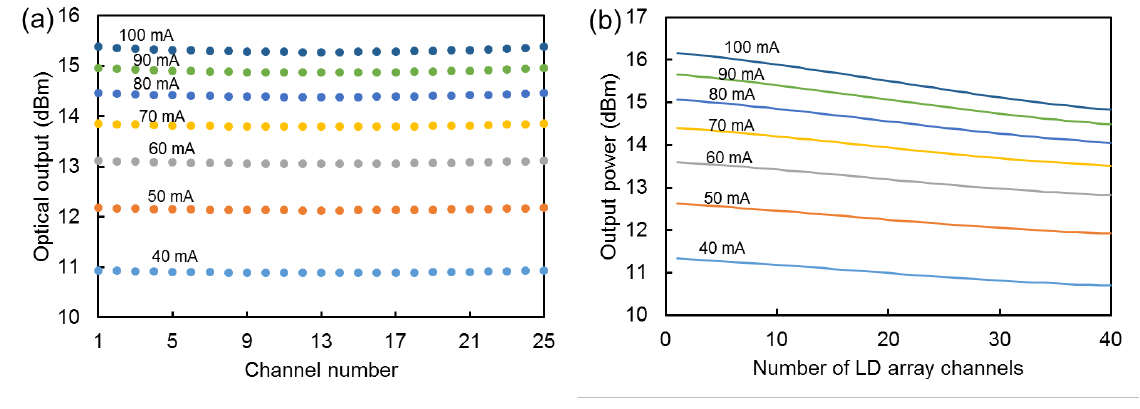
Figure 6. Simulation results of LD array at various injection currents. ( a ) Optical output for each channel in 25-channel LD array considering thermal interference between channels in LD array chip; ( b ) Optical power for central channel against number of LD array channels.